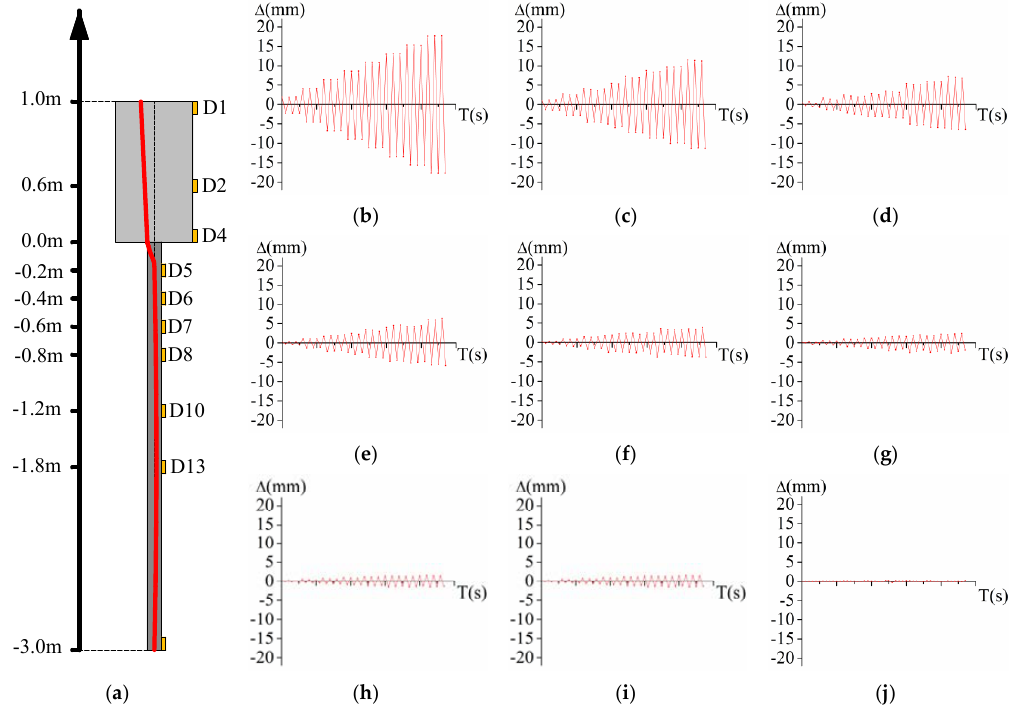
Figure 19. Accumulative deformation of each measurement point.